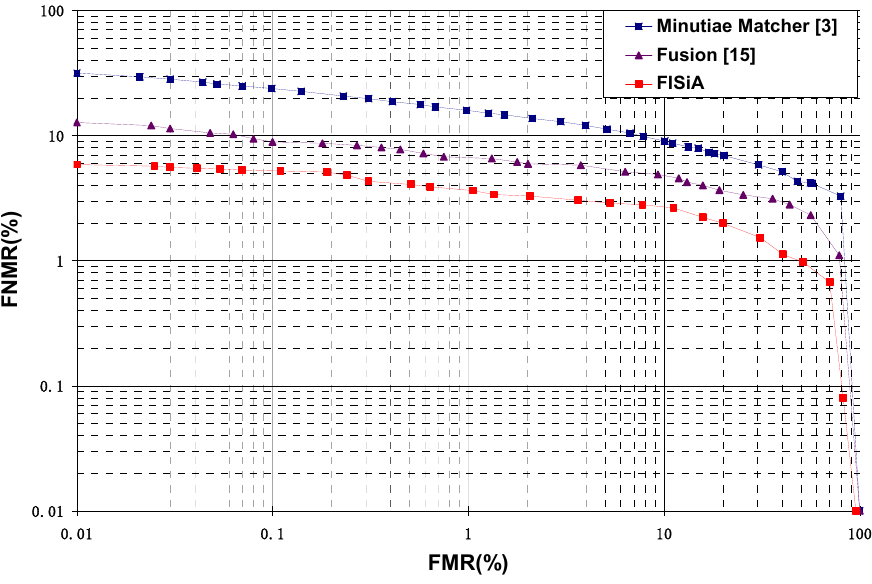
Figure 9. Comparison on a specific database, DB_Swipe.